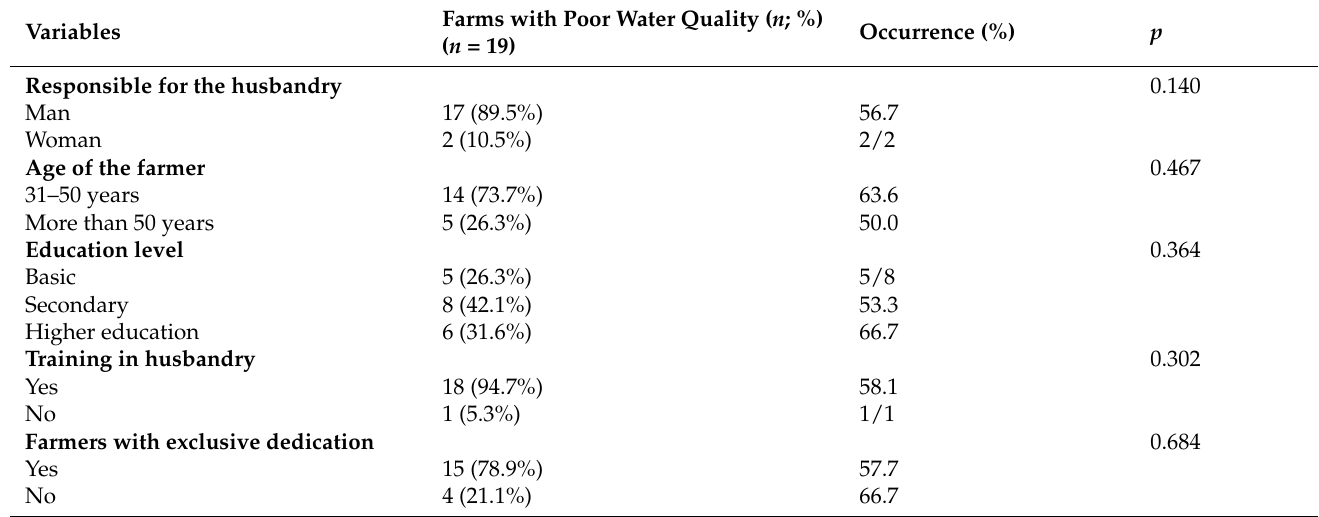
Table 2. Proportion of cattle farms in Portugal with poor water quality according to characteristics of the